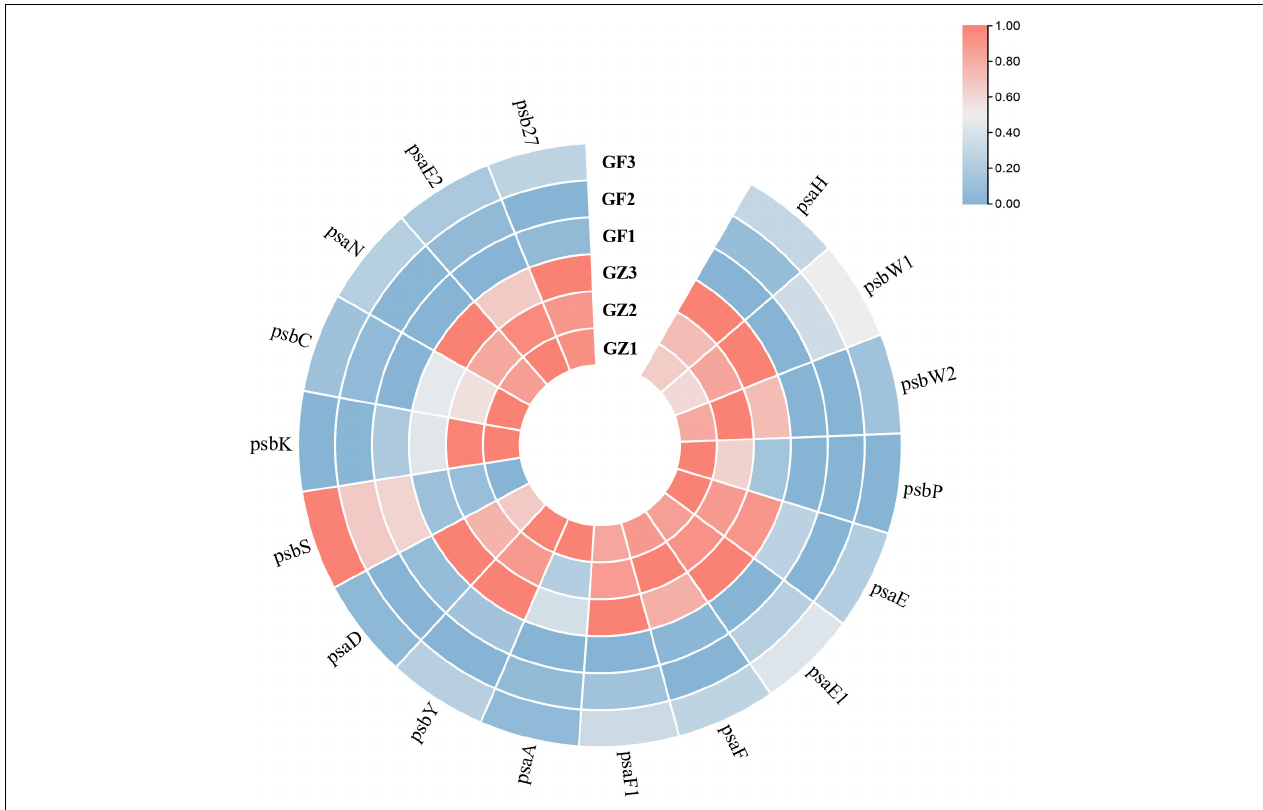
FIGURE 6 | The heatmap of significantly different genes encoding proteins involved in photosystem I (PS I) and photosystem II (PS II) reaction center between GZ and GF in T. hemsleyanum . The color bar represents the normalized fold change